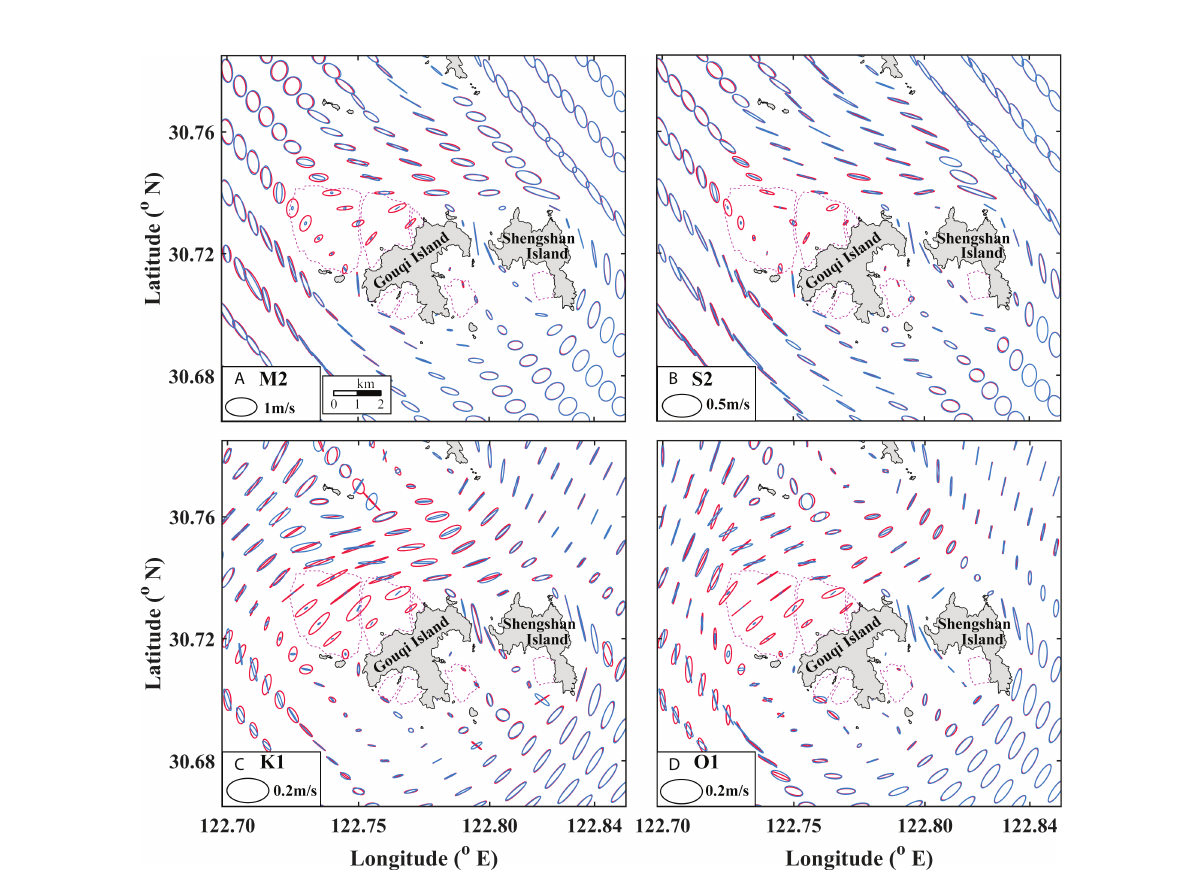
FIGURE 9 Modeled tidal ellipse in the surface layer (depth=0.1d, where d is local depth) with (blue) and without (red) farm. (A) M 2 semi-tide. (B) S 2 semi- tide. (C) K 1 diurnal tide. (D) O 1 diurnal tide. The pink dash lines indicate the borderlines of mussel